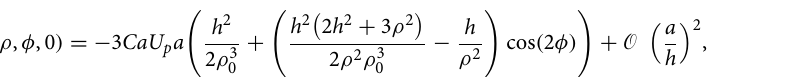
0, z 0 ) is shown. Parameters are (cid:31) = =